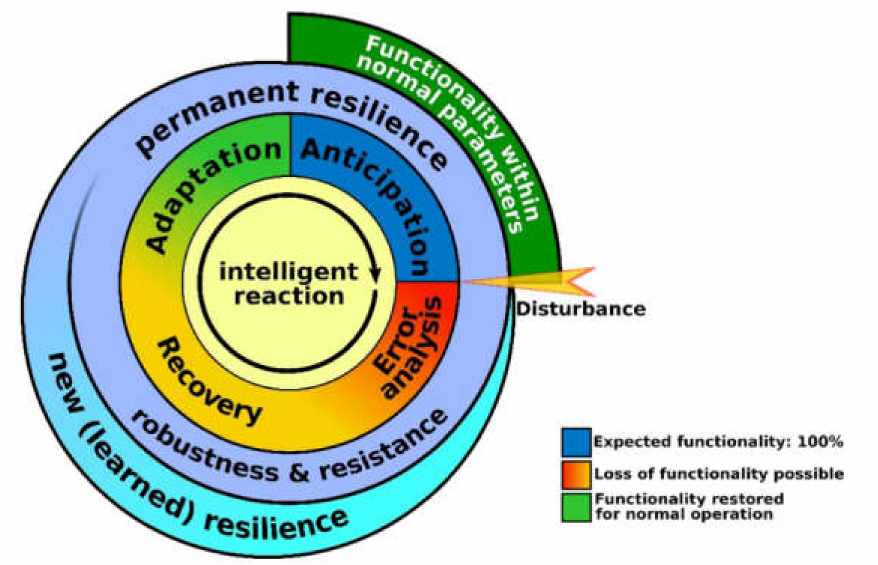
Figure 5. Schematic representation of the key actions anticipation, resilience (permanent methods and new (learned) methods), recovery and adaptation, and the added key action error analysis (source: